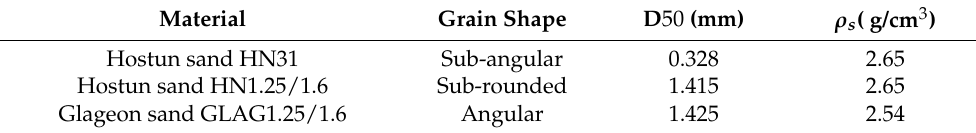
Figure 9. Different types of Granular material tested: ( a ) Silica sand HN1.25/1.6 ( D 50 = 1.415 mm); ( b ) Silica sand HN31 ( D 50 = 328 µm); ( c ) Limestone Glageon sand ( D 50 = 1.425 mm). Table 1. Sand description: shape, mean diameter, and particle density. Sand specimens were also tested at controlled moisture contents of 0%, 5%, and 10%.